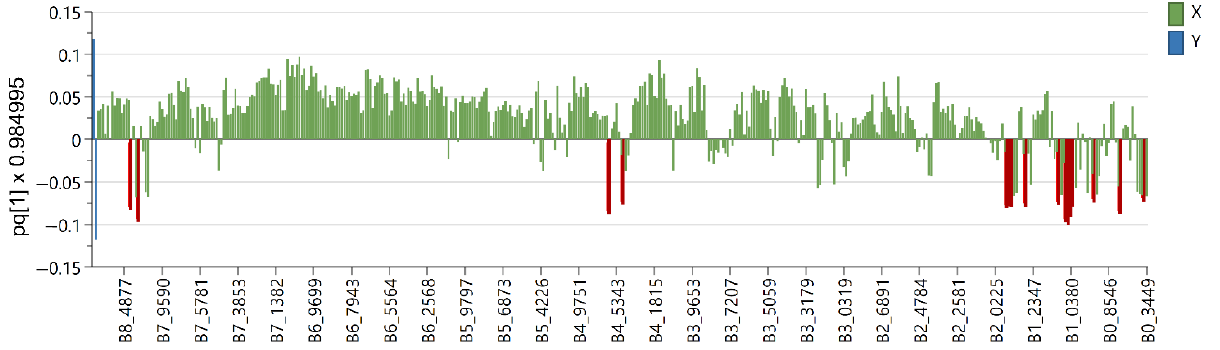
Figure 8. Loading plots with red and brown marked variables characteristic for E. cyparissias (Y variables—loading vectors scaled to unit length) in comparison to other species (X variables—chemical shift), obtained from the OPLS-DA model.